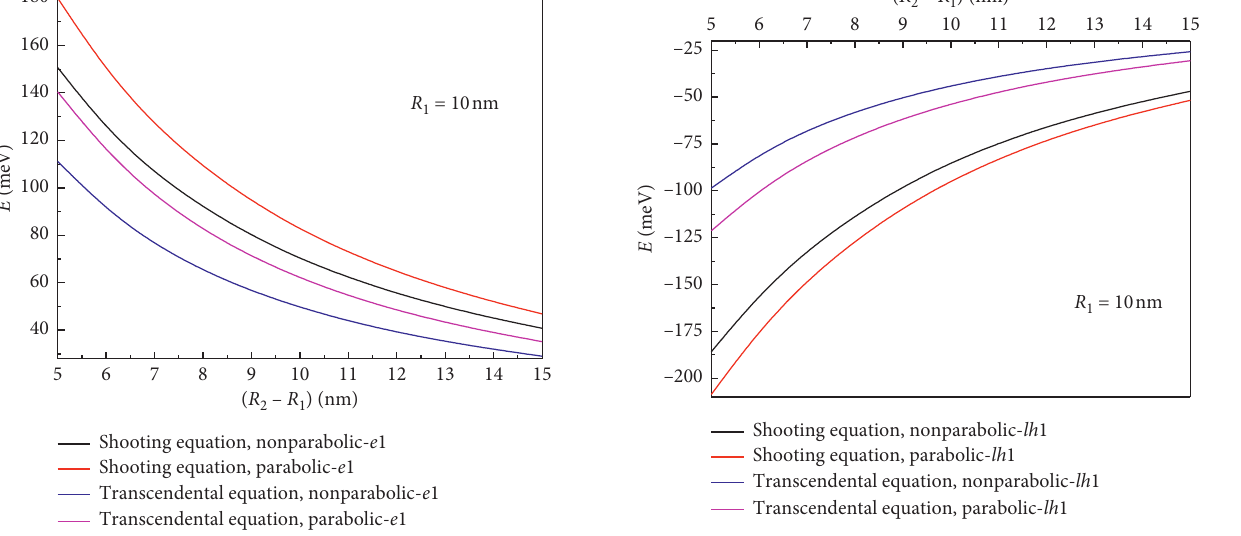
Figure 11: The dependence of the electron energy on the thickness of the layer of a cylindrical quantum nanorod with a finite